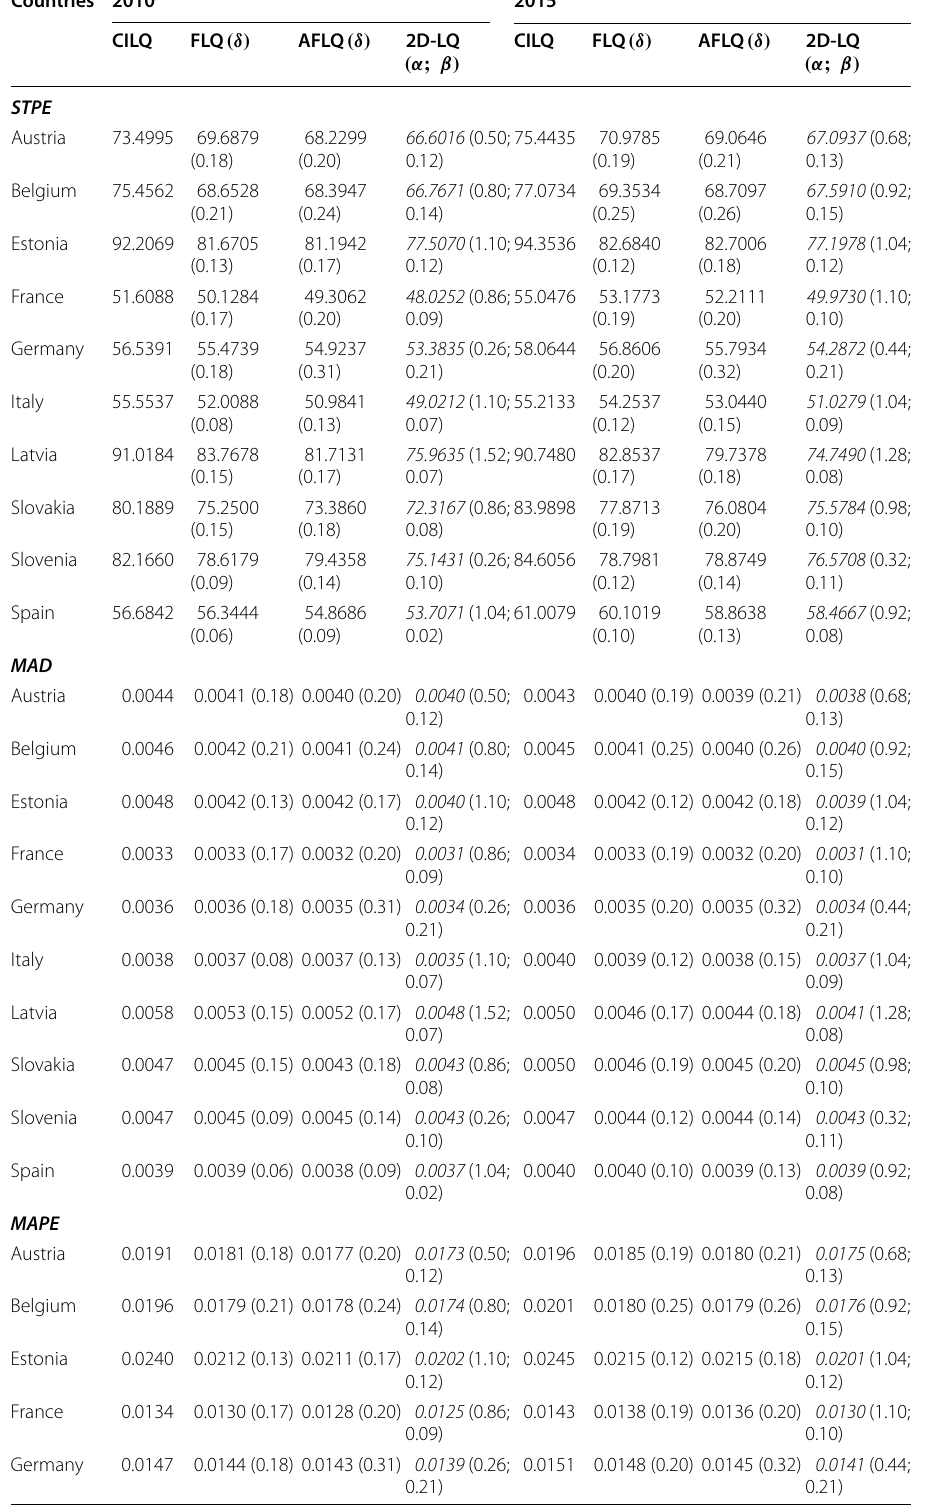
Table 1 Assessment of IO table projections via LQs for EA‑19 countries (2010 and 2015) Countries